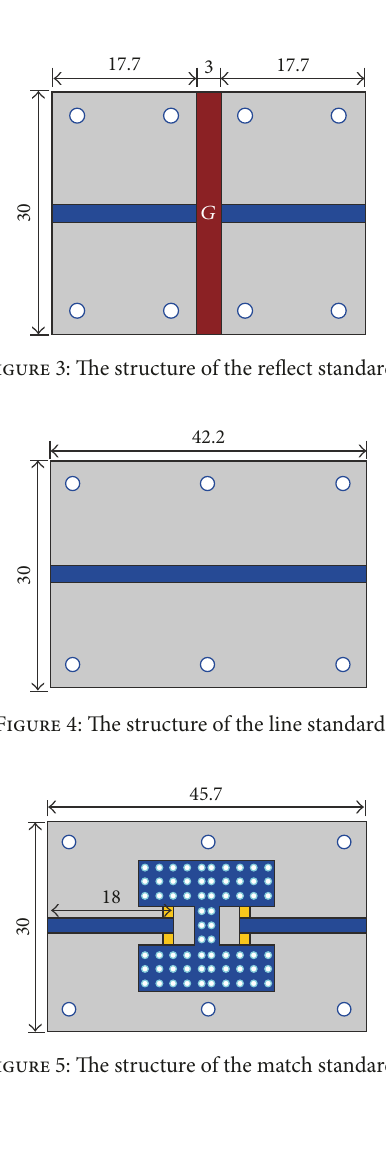
Based on the calibration standards and the measurement structure, the measurement fixture is designed and shown in Figure 7. The leveling screws are used to bring the instrument into level. The base can prevent the structure from tipping over. The movable panel is used to adjust the length so that different measurement standards can fit in. The steel